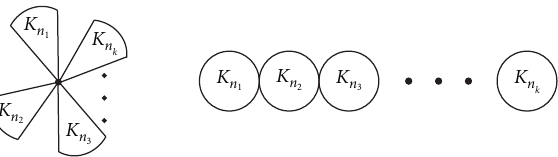
Figure 1: A clique star and a clique